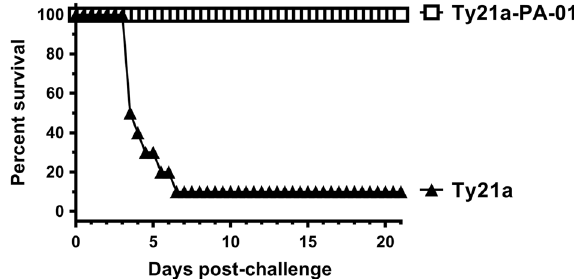
Fig. 3 Ty21a-PA-01 protects mice from lethal spore challenge. Mice were immunized three times with 5 × 10 7 CFU of Ty21a control ( fi lled triangles ) or Ty21a-PA-01 ( open squares ) by the IP route and were challenged two weeks after dose 3 with Sterne spores at a dose of 4.9 LD 50 by intranasal installation and monitored twice daily for 21 days. Mean time to death (TTD) was calculated for the controls. As noted, 1 of 10 control mice immunized with Ty21a and 20/20 mice immunized with Ty21a-PA-01 survived ( p = 2.2 × 10 − 8 , Fisher ’ s exact test, two-tailed). For the nine control mice that died, the mean TTD was 4.2 ± 0.1 (mean ± SD) days